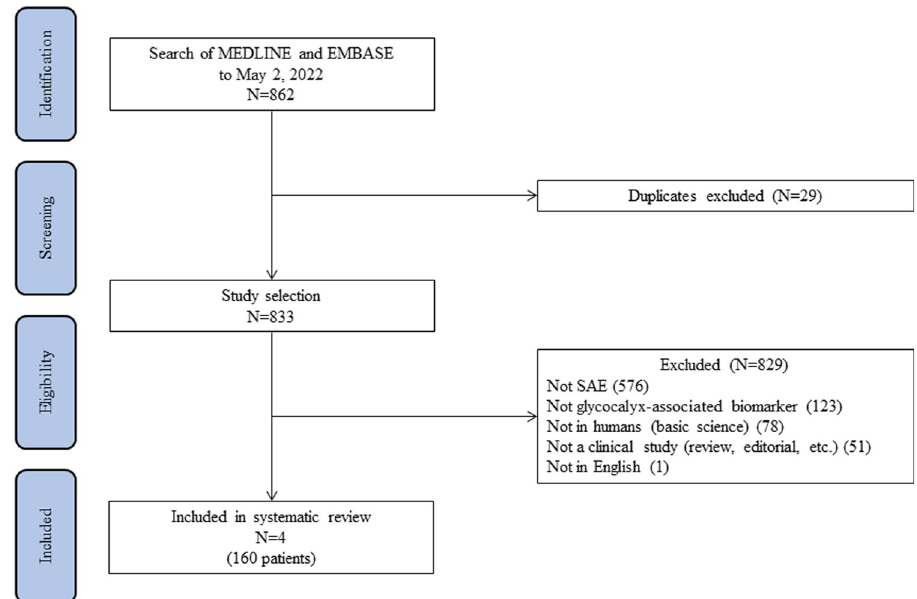
Fig 1. The PRISMA flow diagram. Our initial search yielded 862 citations, of which 29 duplicated were excluded. The abstracts of the remaining 833 citations were carefully checked and 829 were excluded. Ultimately, 4 studies were included in this